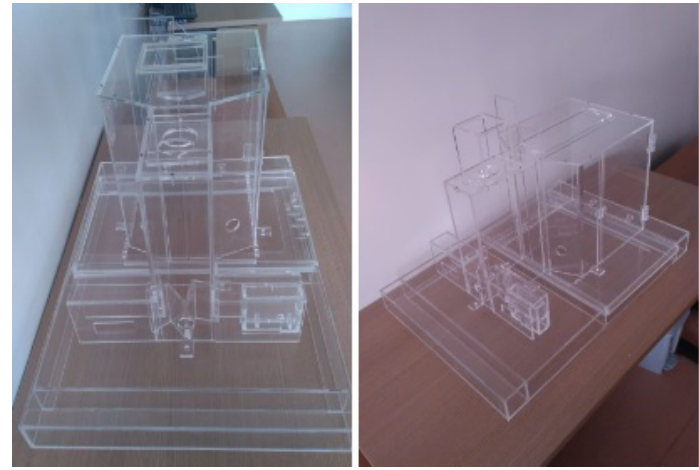
Figure 15. Final assembled behavioral box in front and oblique views.